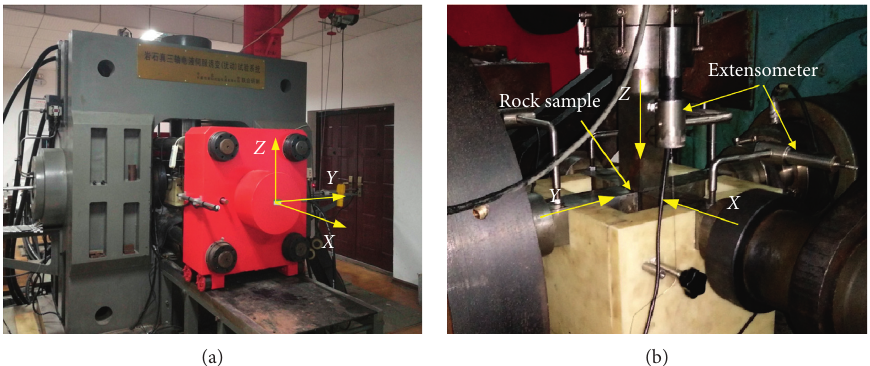
Figure 2: TRW-3000 rock true-triaxial test system: (a) overall appearance and (b) internal loading